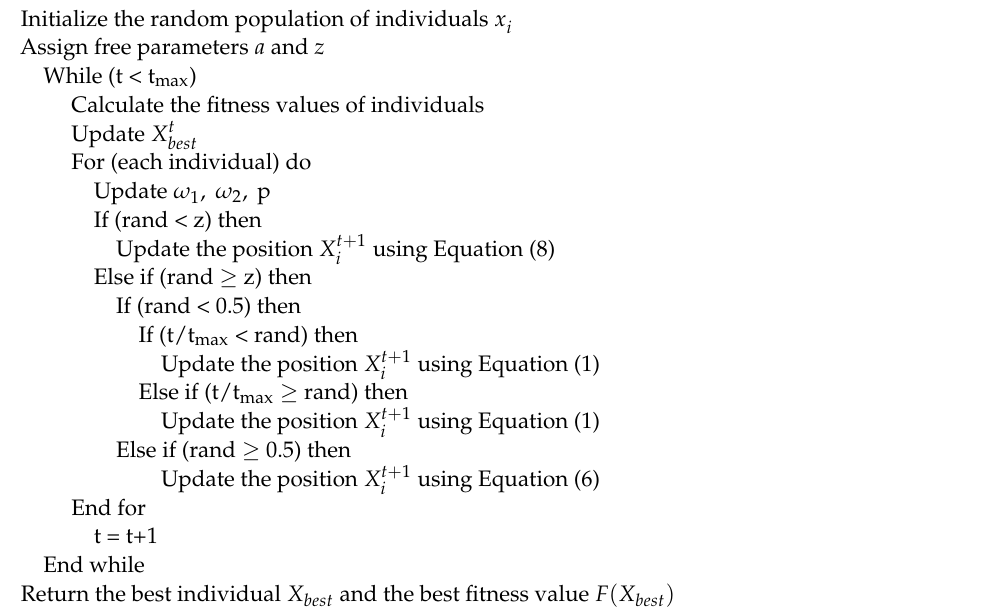
Algorithm 1. Pseudocode for Improved Tuna Swarm Optimization